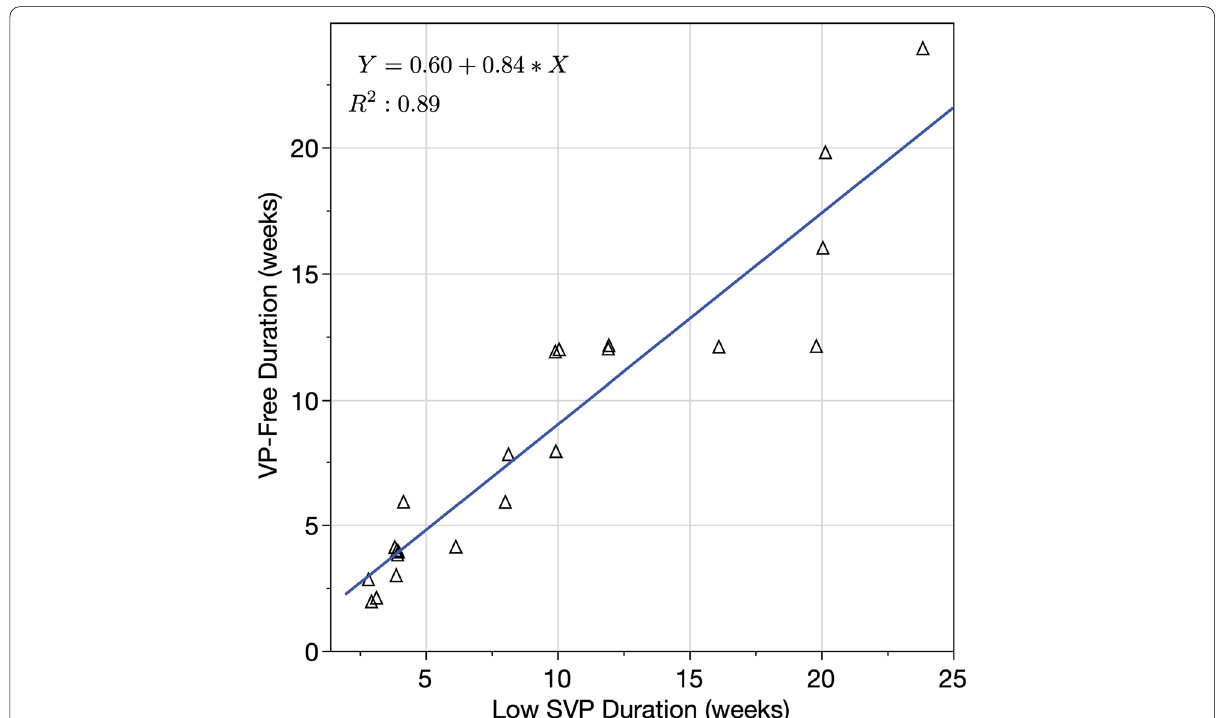
Fig. 5 Correlation between VP‑free duration and low SVP duration for mAb X DP. The 24 formulations (listed in Table 1) were stored at 5 °C and represent unique combinations of [mAb], initial [PS20], and pH. Each formulation was monitored at 12 time points over 24 weeks for VPs (by the Ph. Eur./USP method) and cumulative SVP counts ( 2 µm particles/mL by HIAC liquid particle counter). SVP count threshold of < 350 particles/mL was ≥ used to determine the low SVP duration (in